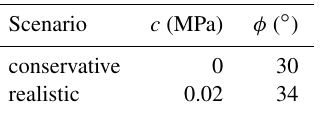
Figure 3. Perspective view of 3D IE discretization of the three faults located in the surrounding of the Romagna reservoir and in- cluded into the geomechanical model. Table 2. Safety factors for each geomechanical